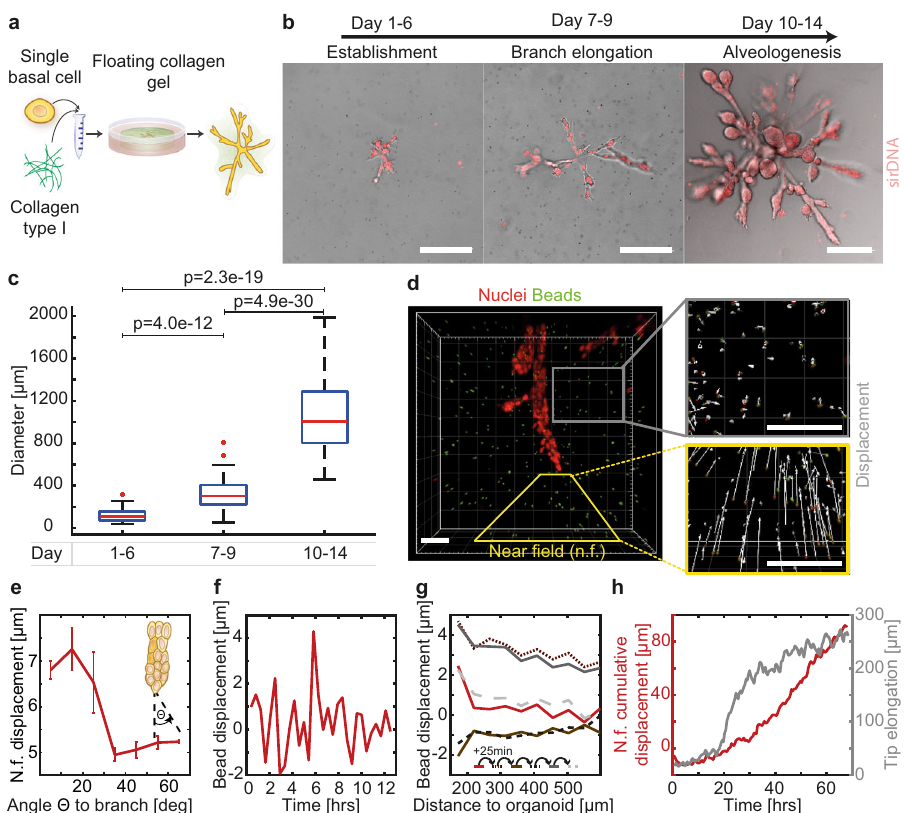
Fig. 1 Human mammary gland organoids invade the ECM by non-continuous contractions. a Schematic overview of 3D culture: single primary human basal mammary epithelial cells are cultured in fl oating collagen gels. b Characteristic organoid morphology at three developmental stages (Establishment n = 36 organoids, Branch elongation n = 75 organoids, Alveologenesis n = 111 organoids). Nuclei are visualized using sirDNA. c The organoid diameter of the long axis during the different stages reveals an increase in diameter during the elongation phase (Establishment n = 36 organoids, Branch elongation n = 75 organoids, Alveologenesis n = 111 organoids). Box plots indicate median (red line), 25th, 75th percentile (blue box) and 5th and 95th percentile (whiskers) as well as outliers (single points). d Live-cell imaging reveals an anisotropic deformation fi eld with strong deformations in front of the branches and no deformation at the sides of the branches ( n = 24 organoids). The near fi eld (n.f.) is de fi ned as area between the branch tip and the ECM 300 µ m away from it. e The deformation is decreasing with increasing angle θ to the branch ( n = 14 organoids). Error bars, mean ± s.d. f The bead displacement is non-continuous over time with contractions towards the branches and relaxations into the opposite direction ( n = 14 organoids). g ECM contractions and relaxations slowly diminish with increasing distance to the organoid. Between each line 25 min passed, highlighting the alternations between contractions of the ECM towards the branches and relaxations away from them ( n = 23 organoids). h The cumulative bead displacement in front of branches is increasing over time (red, n = 5 organoids), while the branch elongation is discontinuous in time (gray, n = 7 organoids). Scale bars, 200 µ m ( b ), 70 µ m ( d ). Organoids were derived from three biologically independent donors (Supplementary Table S1). P values are from a two-tailed Mann – Whitney test and provided in Supplementary Table S5. Source data are provided as a Source Data fi